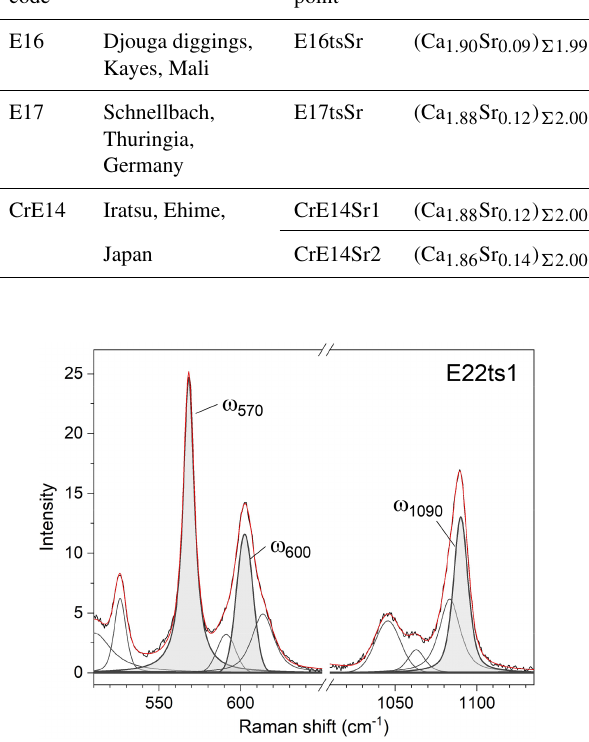
Table 5. Sample localities and chemical formulae of each analytical point in Sr-bearing epidote. Sample